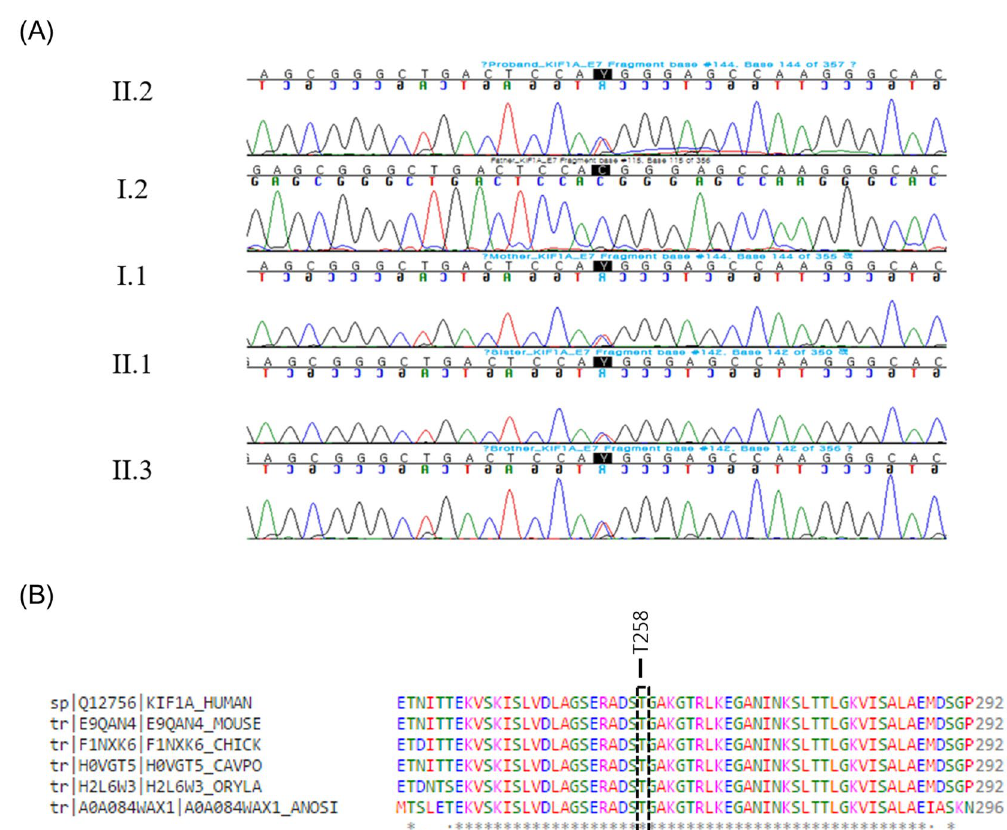
Figure 4. Pathogenic mutation identified in KIF1A. ( A ) Direct sequencing of the proband and her family shows a novel heterozygous mutation of KIF1A gene, c.773C > T (p.Thr258Met). ( B ) The p.T258 amino acid is completely conserved across available different species which is shown in black box. Multiple amino acid sequence alignment was generated using Cluster Omega (http://www.ebi.ac.uk/Tools/msa/clustalo) and includes human (Homo sapiens; Q12756; UniprotKB), mouse (Mus musculus; E9QAN4; UniprotKB), chicken (Gallus gallus; F1NXK6; UniprotKB), Guinea pig (Cavia porcellus; H0VGT5; UniprotKB), Japanese rice fish (Oryzias latipes; H2L6W3; UniprotKB), and Mosquito (Anopheles sinensis; A0A084WAX1;